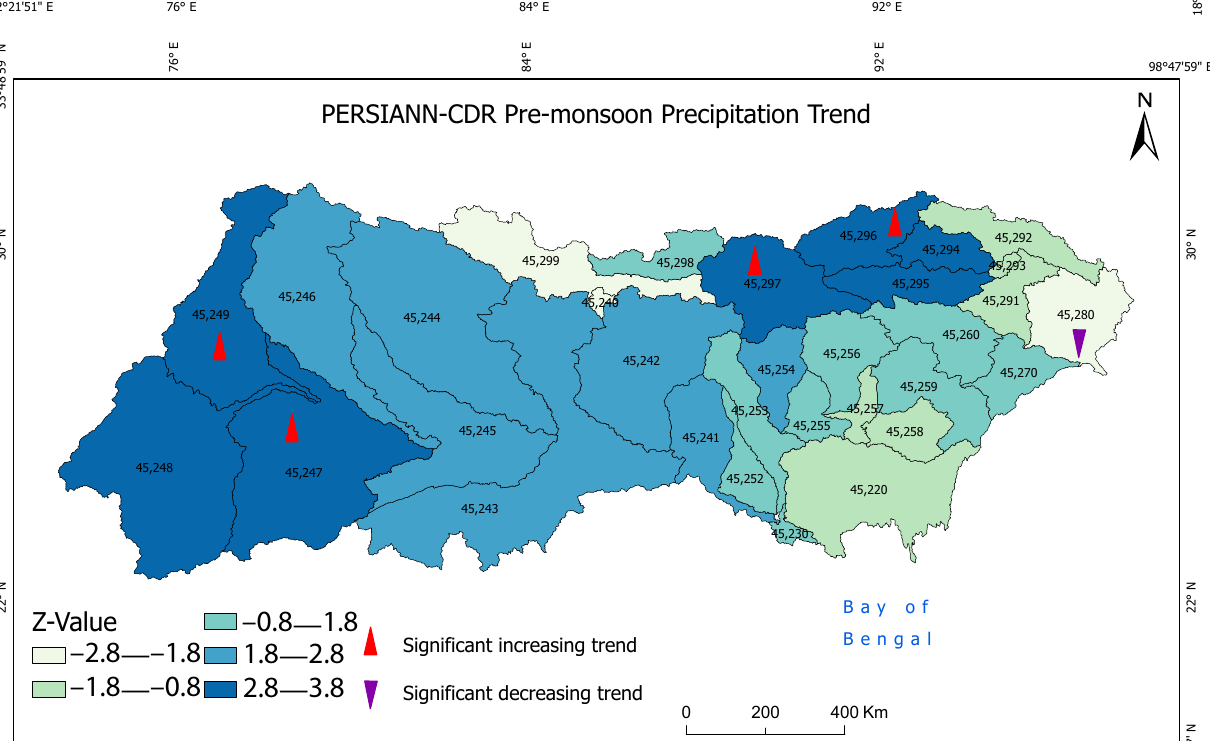
Figure 5. Pre-monsoon precipitation trend for ( a ) MSWEP and ( b ) PERSIANN-CDR. Red color upright triangle indicates a significant increasing trend ( p < 0.05), and a purple color downright triangle indicates significant decreasing